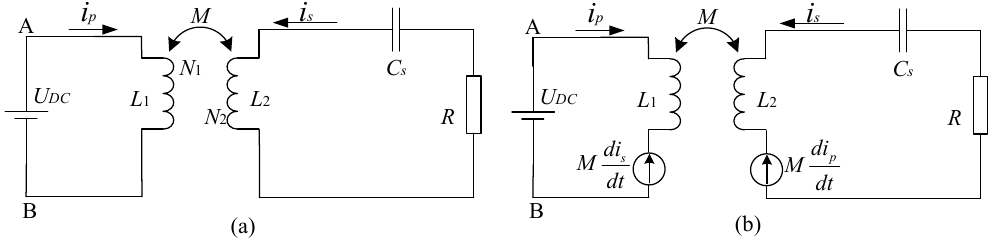
Figure 2. Schematic diagram of IIEIFR system. ( a ) Energy injection stage; ( b ) Free resonance stage; ( c ) Shutdown stage.